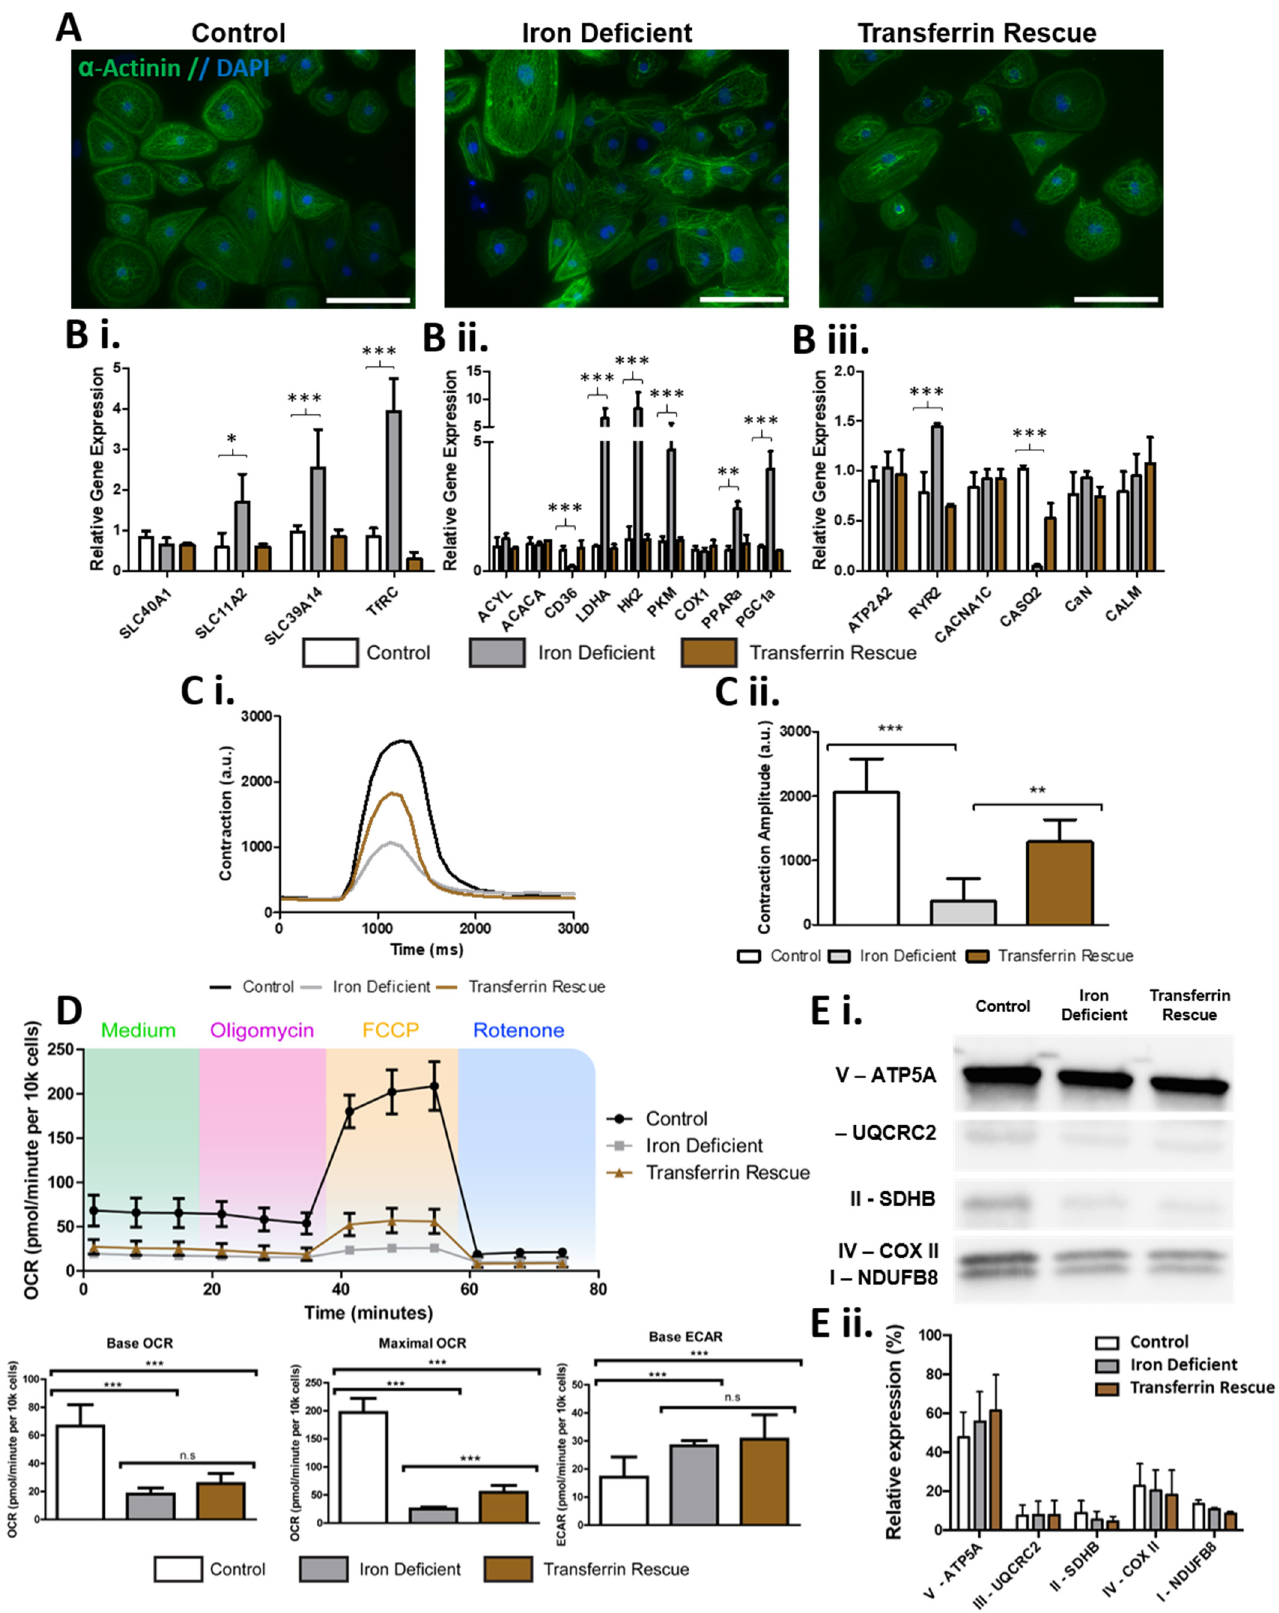
Figure 3. Effects of iron deficiency and transferrin rescue on hiPSC-CMs. In ( A ), alpha-actinin staining (green) and DAPI (blue) is shown for hiPSCs-CMs with iron depletion and transferrin rescue showing high purities of cardiomyocytes. In ( B ), qPCR analysis of iron-deficient and transferrin-